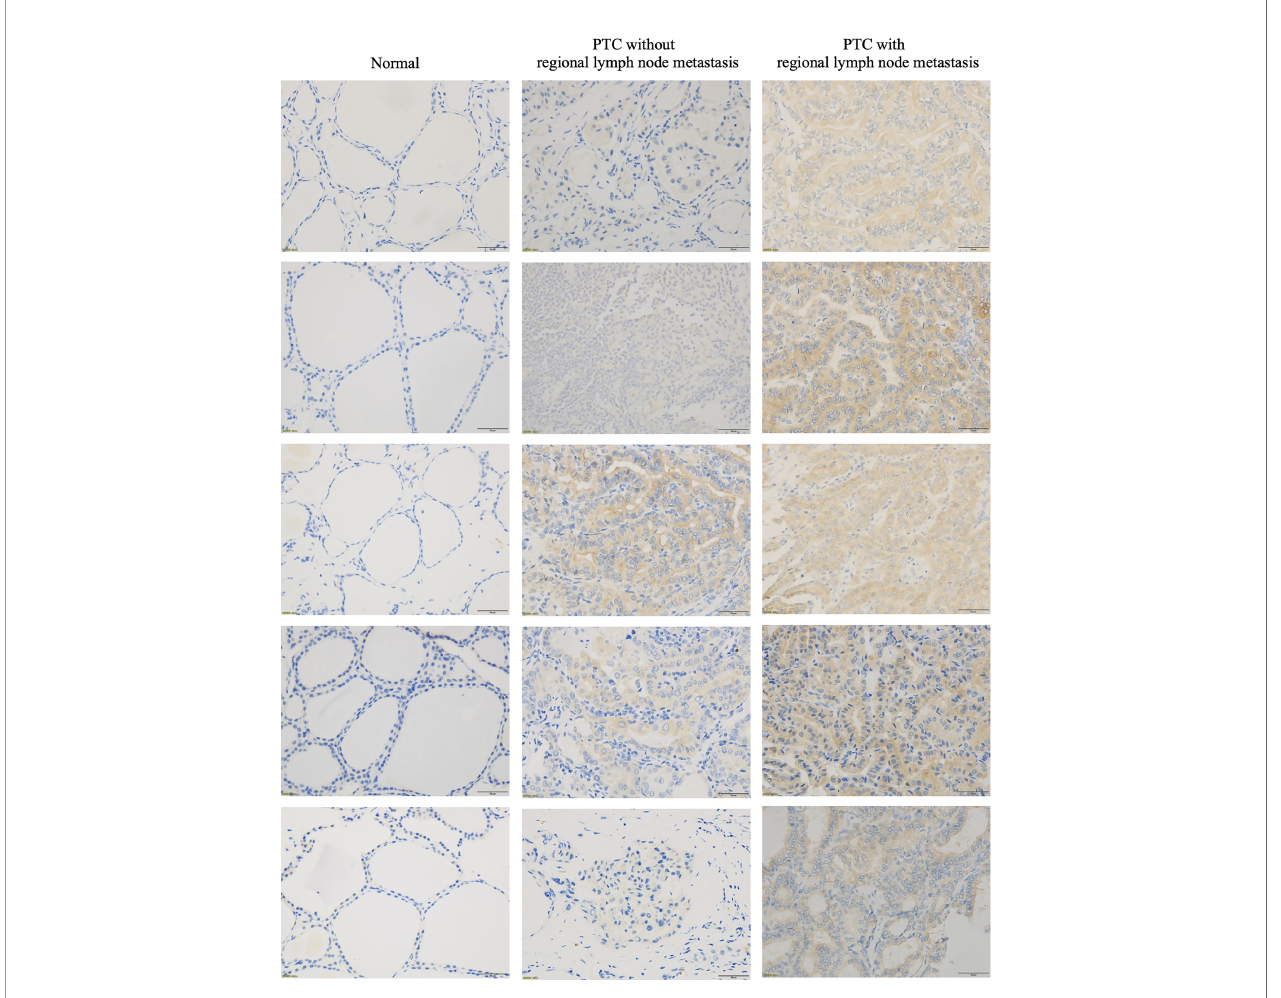
FIGURE 2 | Representative immunohistochemistry assay images of SARG staining in thyroid normal tissues, PTC tissue without regional lymph node metastasis, and PTC tissue with lateral cervical lymph node metastasis. SARG, speci fi cally androgen-regulated gene; PTC, papillary thyroid